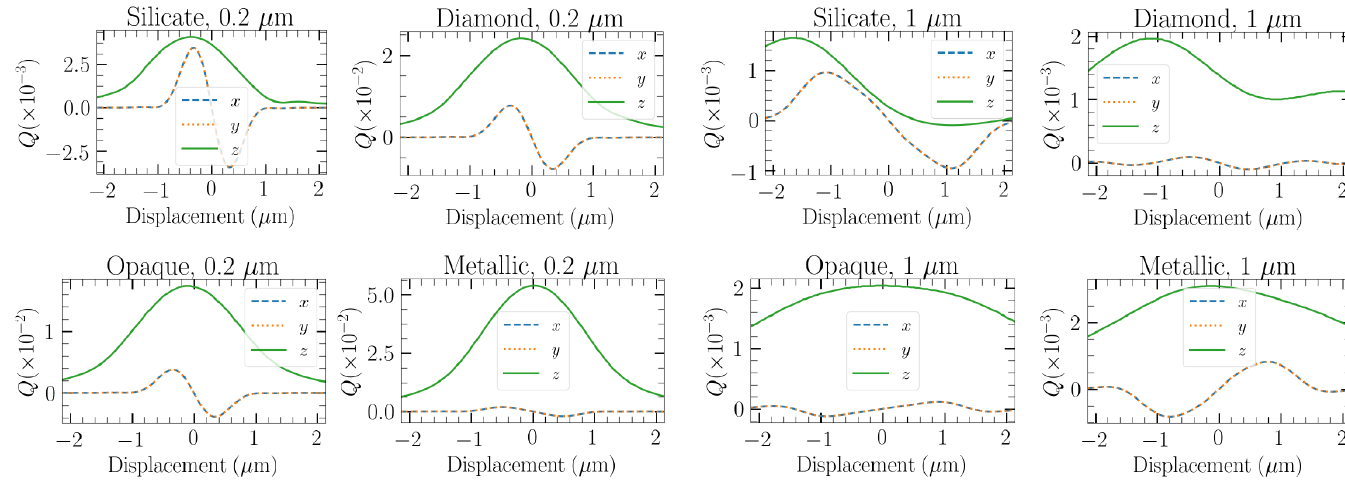
Fig 15. Trap efficiency comparison for the example Gaussian ellipsoid particle of different sizes and compositions.